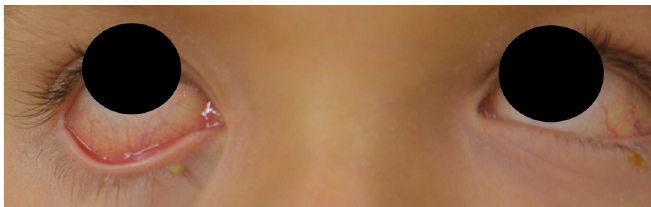
Image 2. Jaundice, icteric sclera, and conjunctival injection, day four of illness.